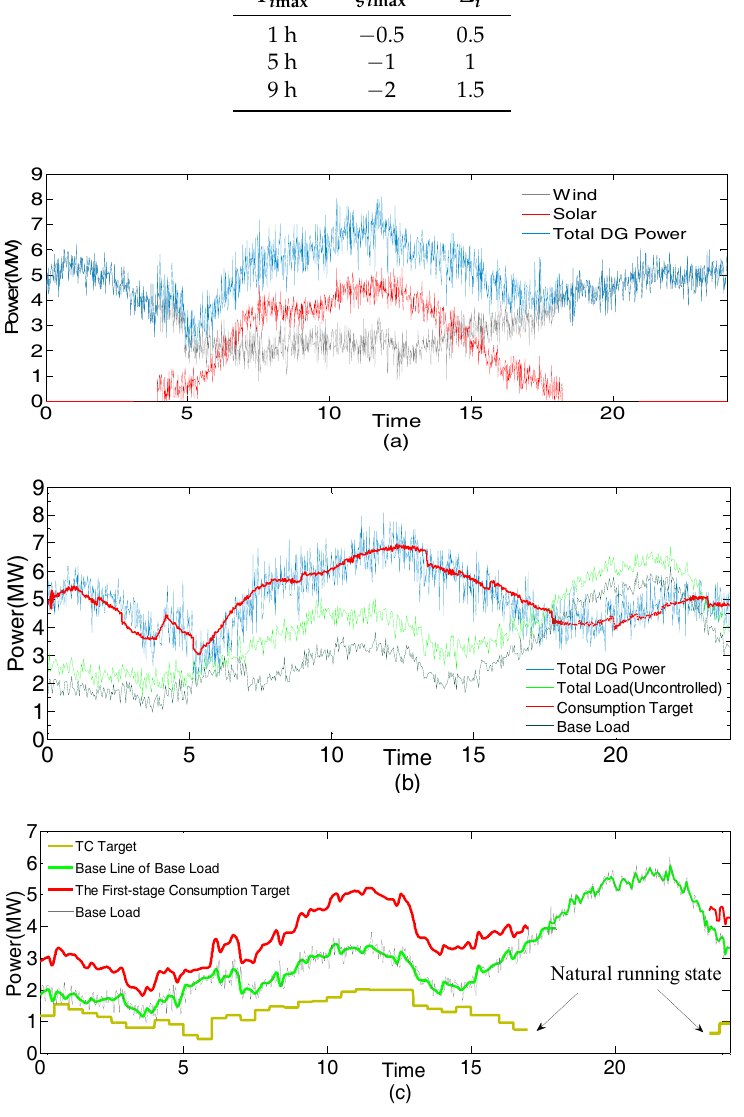
Figure 7. PV, PW, loads’ power and consumption targets profiles. ( a ) PV, PW, total DG power curve; ( b ) total DG power, total load power(uncontrolled), consumption target and base load curve; and ( c ) TC target, the first-stage consumption target and base load curve.